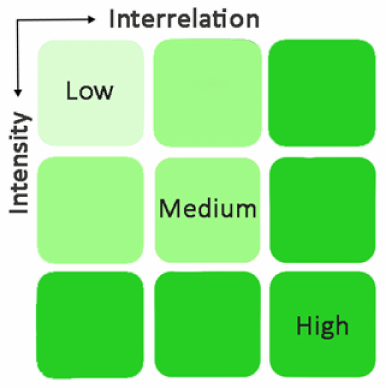
Figure 3. Assessment of the interrelation extent of MSFD–MSPD